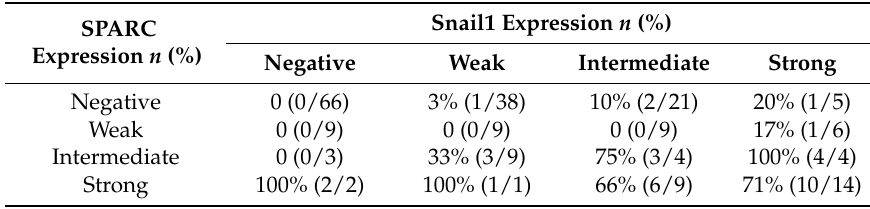
Table 4. Invasion rate with regard to SPARC and Snail1